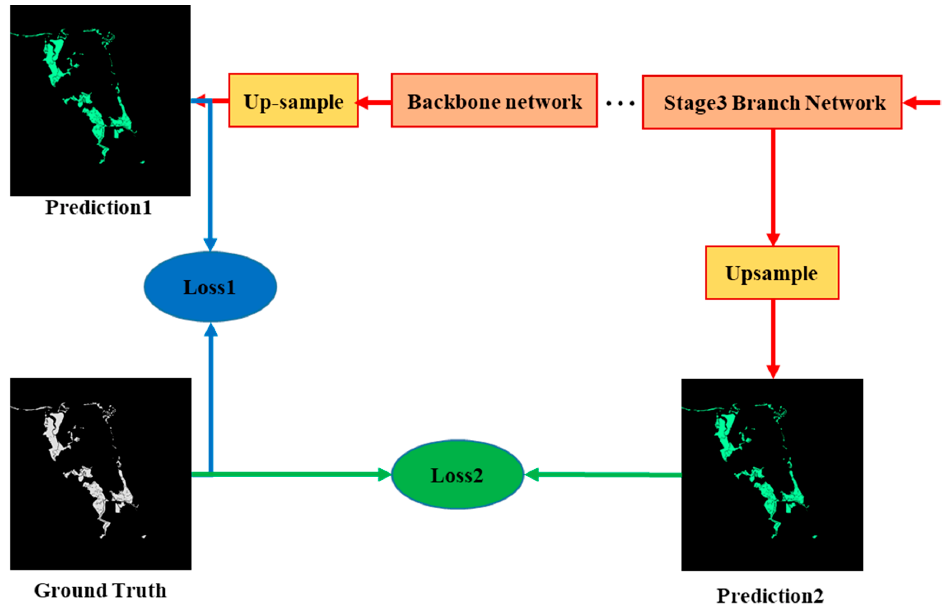
Figure 7. Two loss functions in